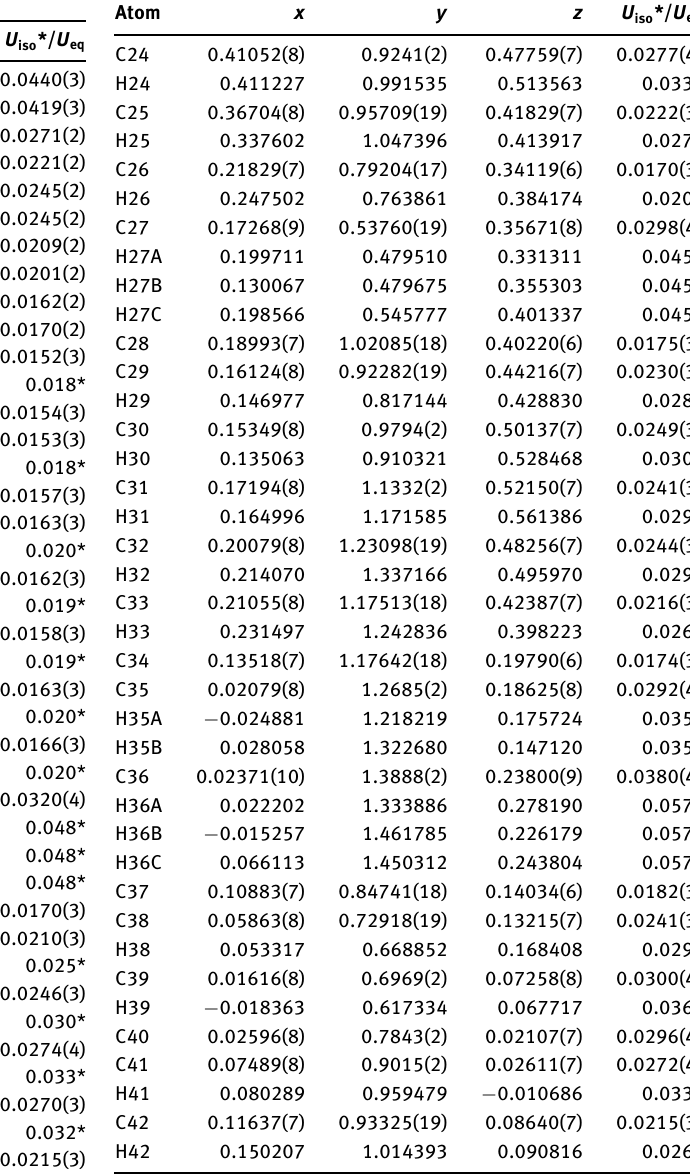
Table 2: Fractional atomic coordinates and isotropic or equivalent isotropic displacement parameters (Å 2